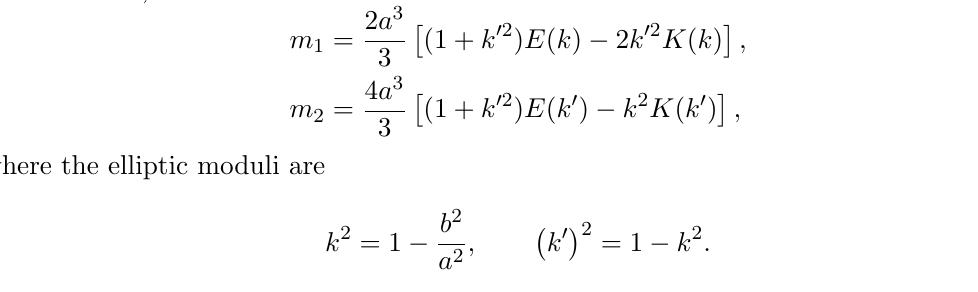
( ~ ) for (cid:15) = 1 (bottom) and (cid:15) = 1 (top) as a function of x = J (cid:15) (cid:0) ( ~ ) in four points which give the (cid:12)rst four values J (cid:15)